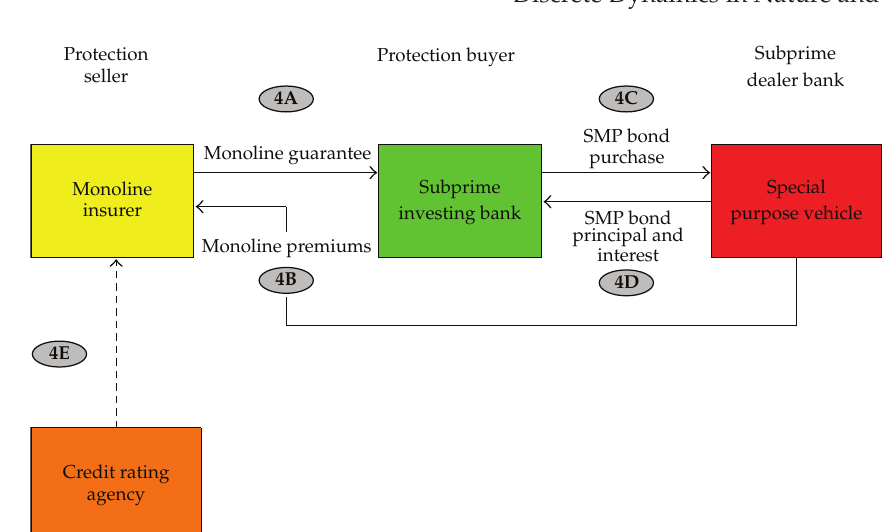
Figure 4: Structured mortgage products wrapped by monoline